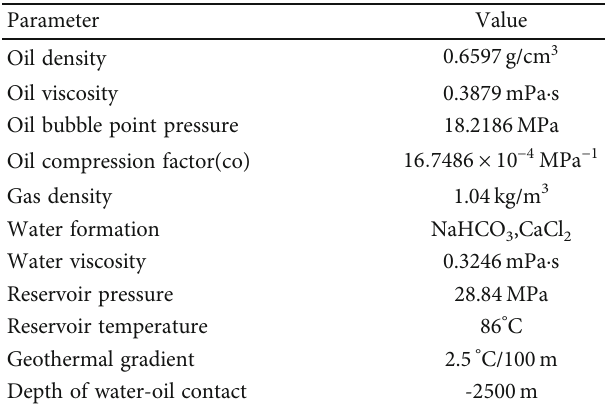
Figure 6: Histogram of porosity (a) and permeability (b) Table 2: General fl uid properties at initial reservoir conditions and initialization parameters used in the modeling.